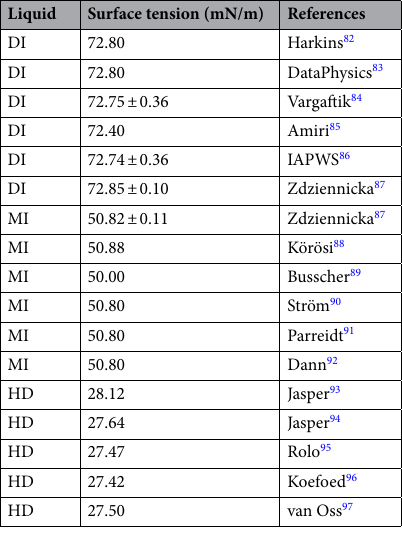
Table 3. Surface tension values from the literature of the selected liquids.